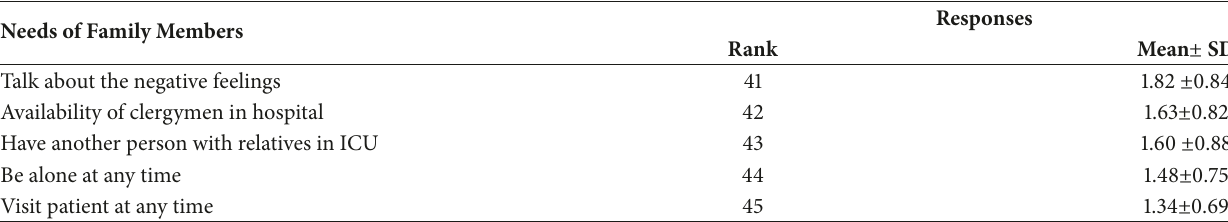
Table 4: Respondents’ perception of five least important needs of family members.